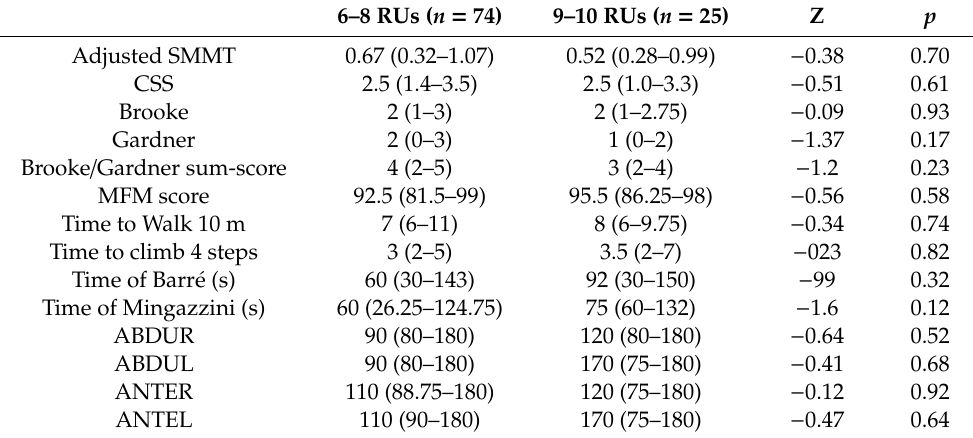
Table 1. Comparison of clinical scales between the two groups of patients with